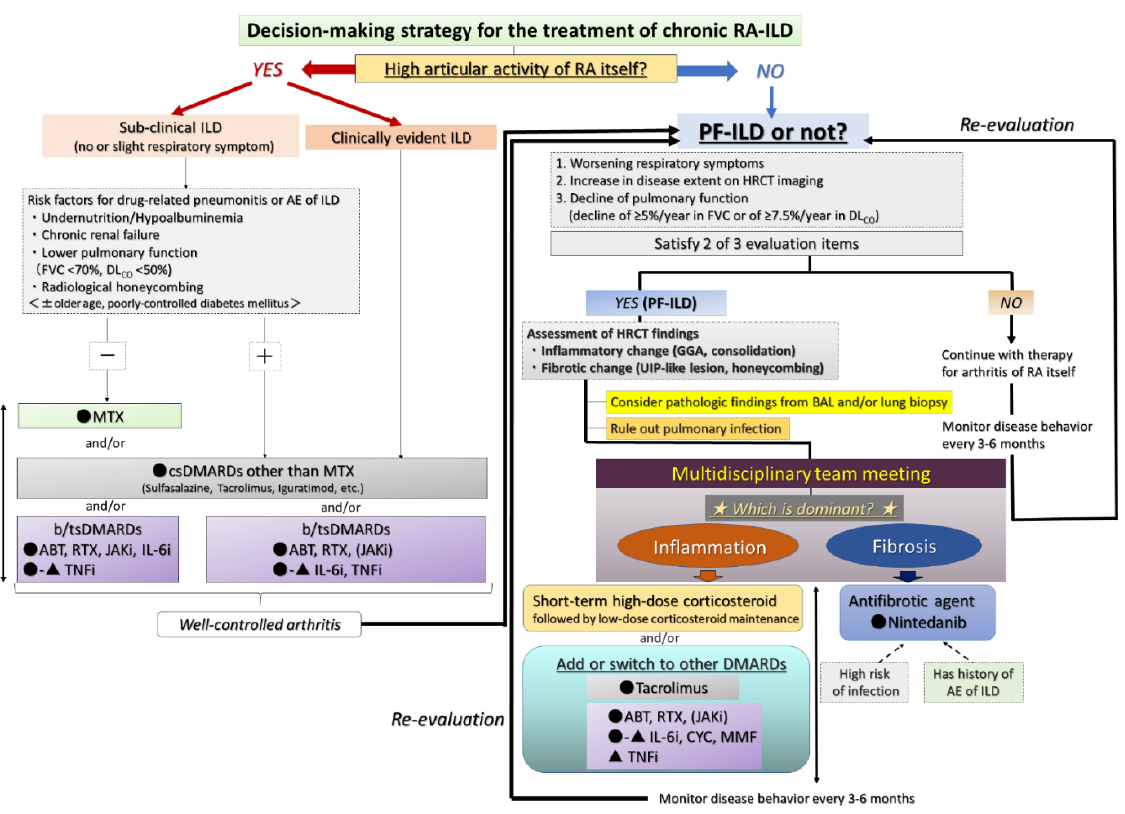
Figure 7. Proposed management algorithm for chronic RA-ILD. Abbreviations: ABT = abatacept; AE = acute exacerbation; BAL = bronchoalveolar lavage; b/tsDMARD = biologic/targeted synthetic DMARD; csDMARD = conventional synthetic DMARD; DLCO = diffusing capacity for carbon monoxide; DMARD = disease-modifying anti-rheumatic drug; FVC = forced vital capacity; GGA = ground-glass attenuation; ILD = interstitial lung disease; JAKi = Janus kinase inhibitor; MTX = methotrexate; PF-ILD = progressive fibrosing ILD; RA = rheumatoid arthritis; RTX = rituximab; IL-6i = interluekin-6 inhibitor; CYC = cyclophosphamide; MMF = mycophenolate mofetil; TNFi = tumor necrosis factor-inhibitor; UIP = usual interstitial pneumonia.